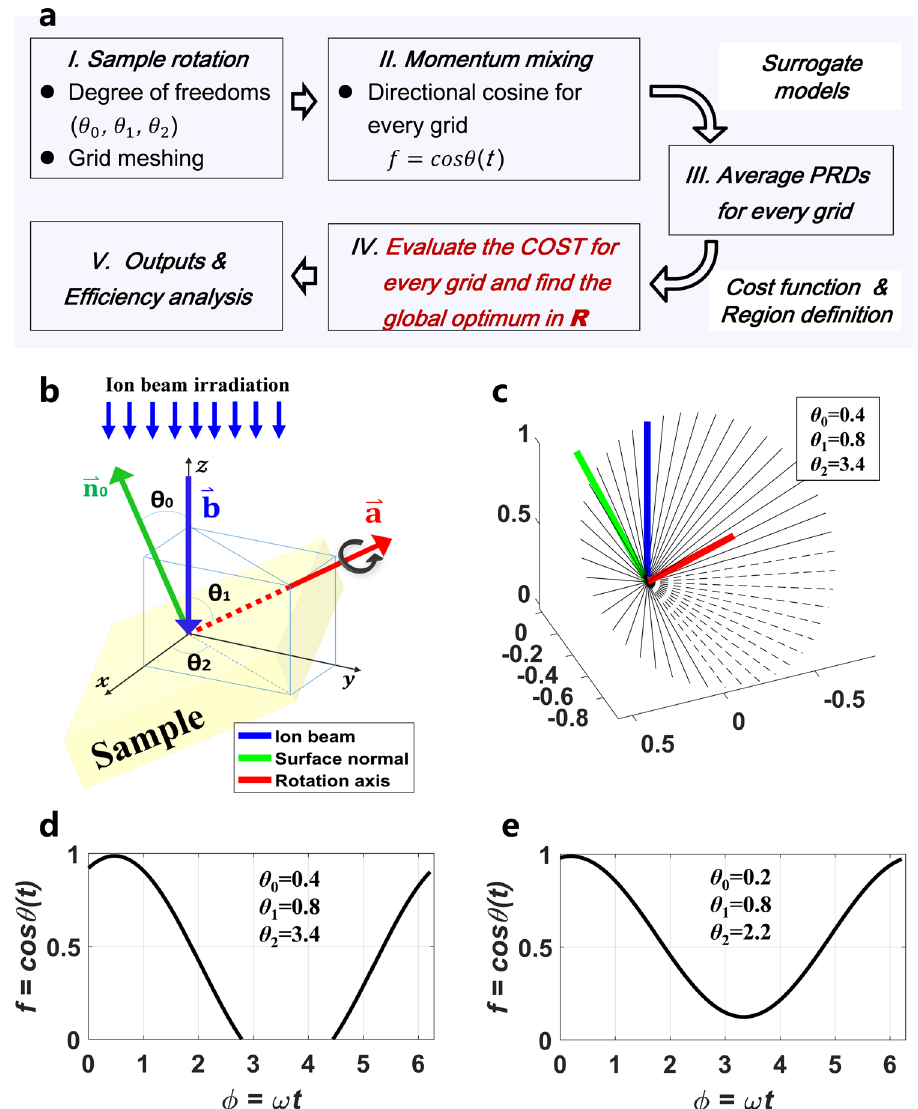
Fig. 3 Illustration of SSS framework. a Work fl ows of SSS. b Schematic setup of SSS in Cartesian coordinate system, the ion momentum status ( E , θ ) in SSS during the sample rotation is determined by surface inclination angle θ mixing f in 3D c and linear d forms for speci fi c parameters θ 0 ¼ 0 : 4 ; θ 1 ¼ 0 : 8 ; θ 2 ¼ 3 : 4 ð Þ , for which not all the ions participate in the averaging. e Another f pro fi le in one-linear form with speci fi c parameters θ 0 ¼ 0 : 2 ; θ 1 ¼ 0 : 8 ; θ 2 ¼ 2 : 2 ð Þ , for which all the ions participate in the